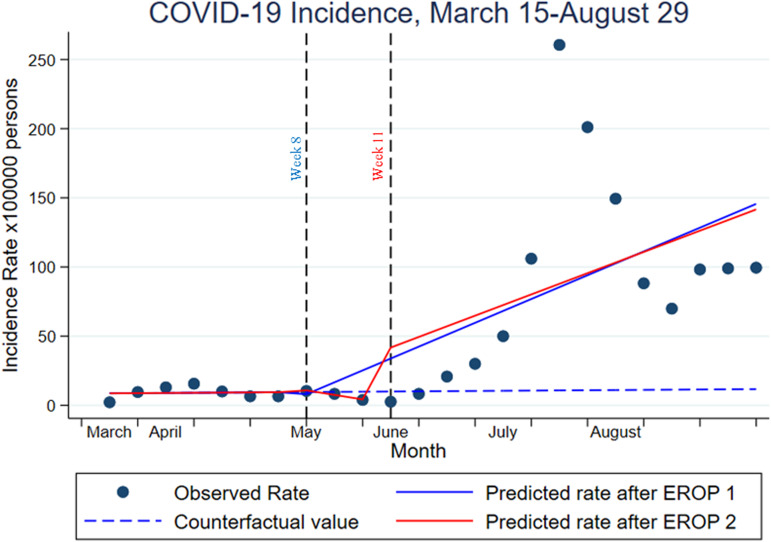
Impact of reopening business on COVID-19 depicted incidence rate of COVID-19 with observed rate (black dots), estimated counterfactual trend of COVID-19 if economic reopening business (EROP) did not happen (dash blue line), predicted trend after EROP 1 implemented (solid blue line) and predicted trend after EROP 2 implemented (solid red line). Vertical lines at weeks 8 and 11 where the EROP 1 and EROP 2 started.